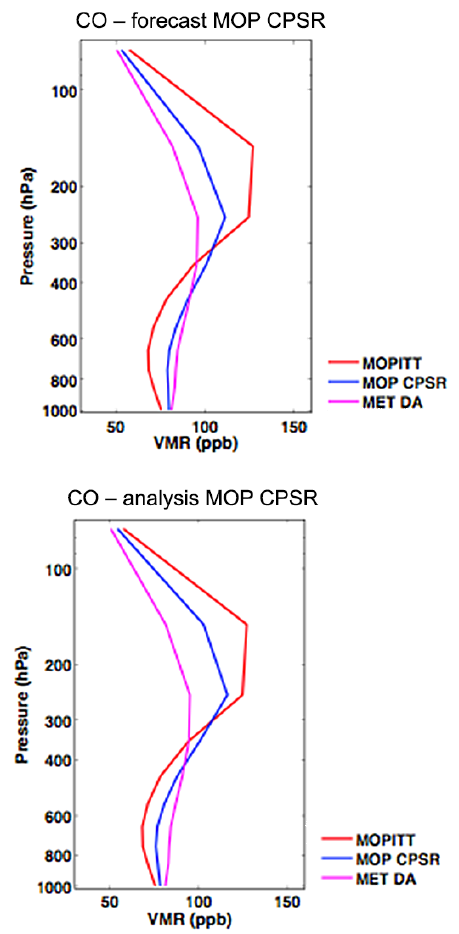
Figure 7. Same as Fig. 3 except for the MOP CPSR